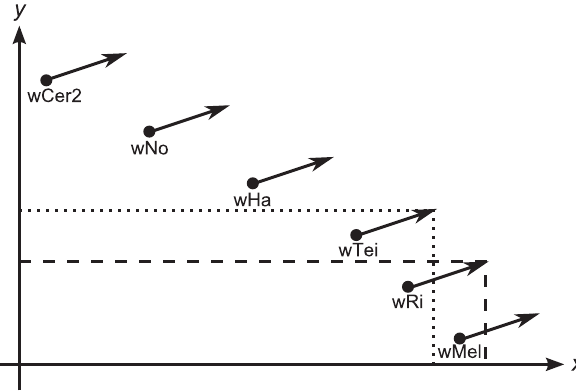
Figure 4. Explanation of the compatiblity relationship using the goalkeeper-model. The points represent the contribution by the corresponding Wolbachia strain to the two mod factors ( 00 x 00 and 00 y 00 ). The black arrow represents the host contribution to rescue. The contribution of a strain to the two resc factors equals its own contribution plus the net host contribution. When both resc factors exceed both mod factors in quantity, rescue is successful. Thus wTei with the help of the net host contribution rescues wRi (indicated by wRi being within the dotted frame). In contrast, wRi can rescue wMel but not wTei (indicated by wMel but not wTei being within the dashed frame).